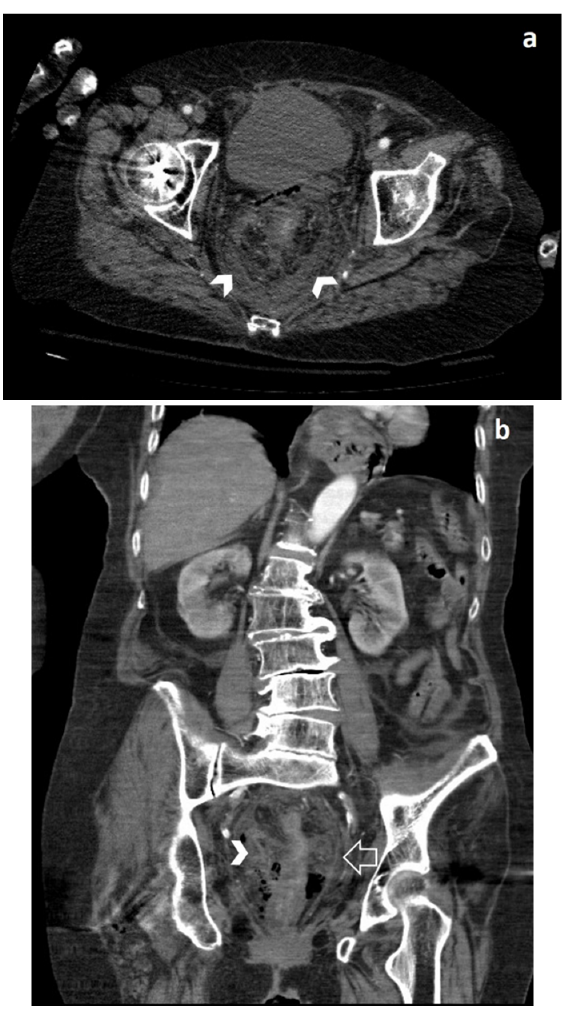
Figure 2. Axial ( a ) and coronal ( b ) CT images show perivisceral fat stranding (arrowheads) and thickening of the mesorectal fascia (open arrow in ( b )).